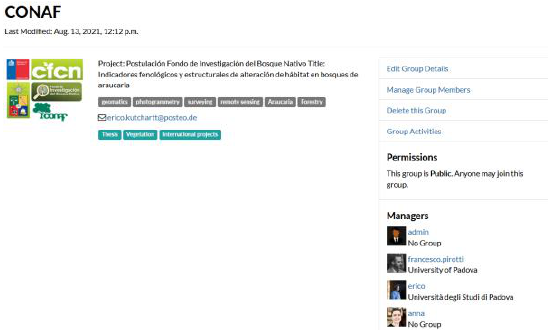
plot. ISPRS-SHY allowed to view the plot position and the data relative to each plot ( Figure 6 ).